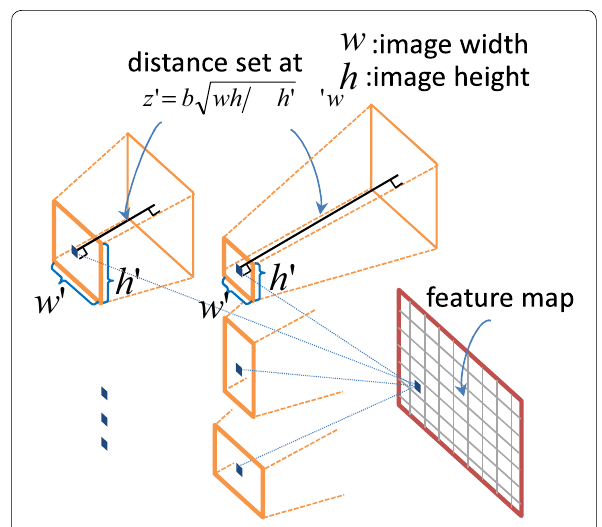
Fig. 8 Diagram of perspective